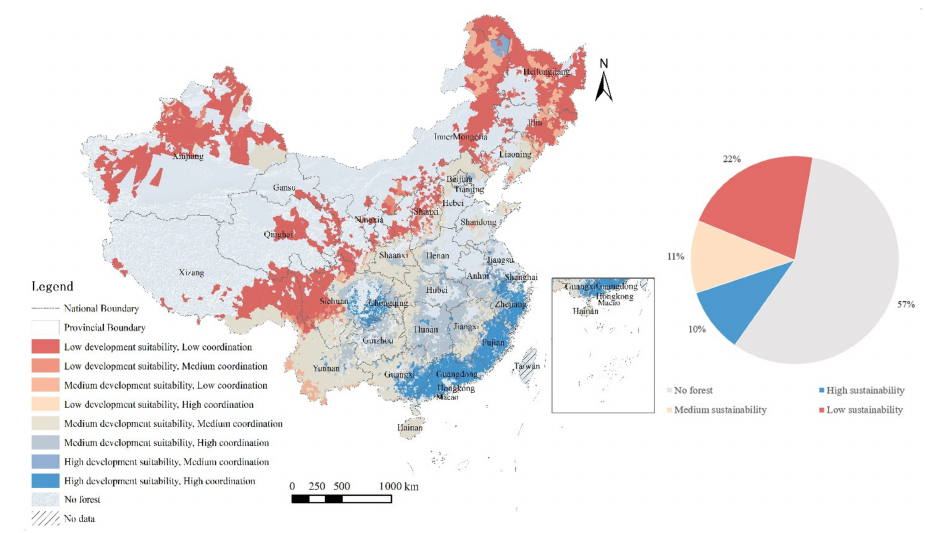
Figure 9. The comprehensive sustainability coordination evaluation results.